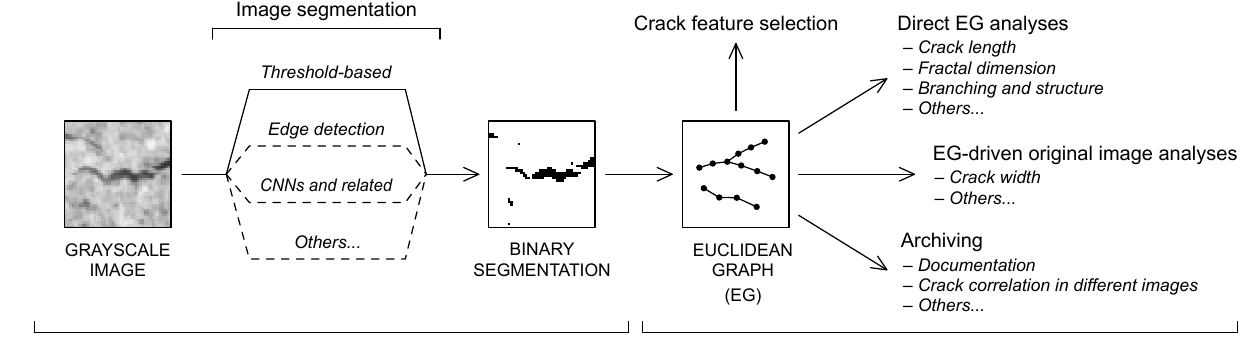
Figure 2. EG-mediated image analysis process. The EG description of the crack pattern can be derived from any segmentation algorithm that results in a binary image, allowing the implementation of automated, EG-based crack analyses to most of the existing crack detection